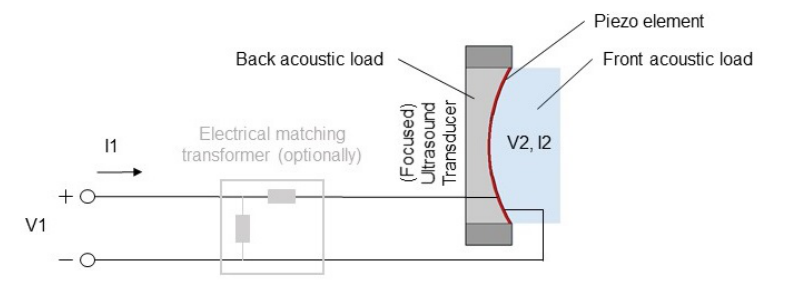
Figure 1. Schematic of a single transducer element system, showing electrical connections, back and front acoustic loading, and electrical matching as an optional part of the network. V 1 and I 1 stand for the voltage and current at the electrical port of the transducer, while V 2 and I 2 represent the acoustic pressure and particle velocity of the front acoustic load, seen as a voltage and current, respectively, in the equivalent circuit